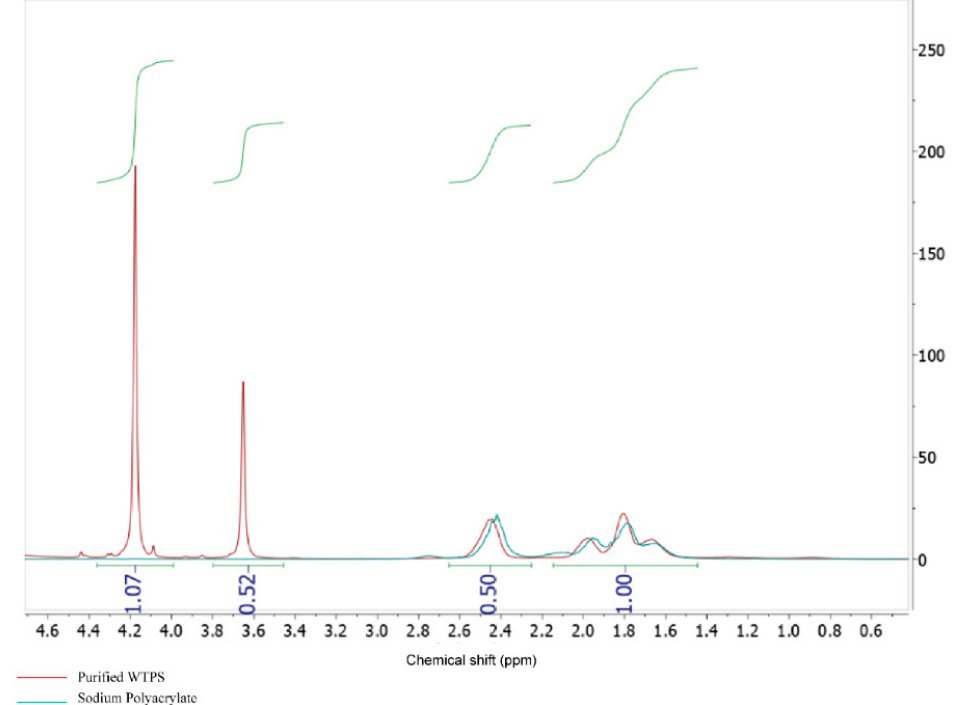
Figure 3. 1 H ‐ NMR spectra of purified WTPS and sodium polyacrylate. Figure 3. 1 H-NMR spectra of purified WTPS and sodium polyacrylate.